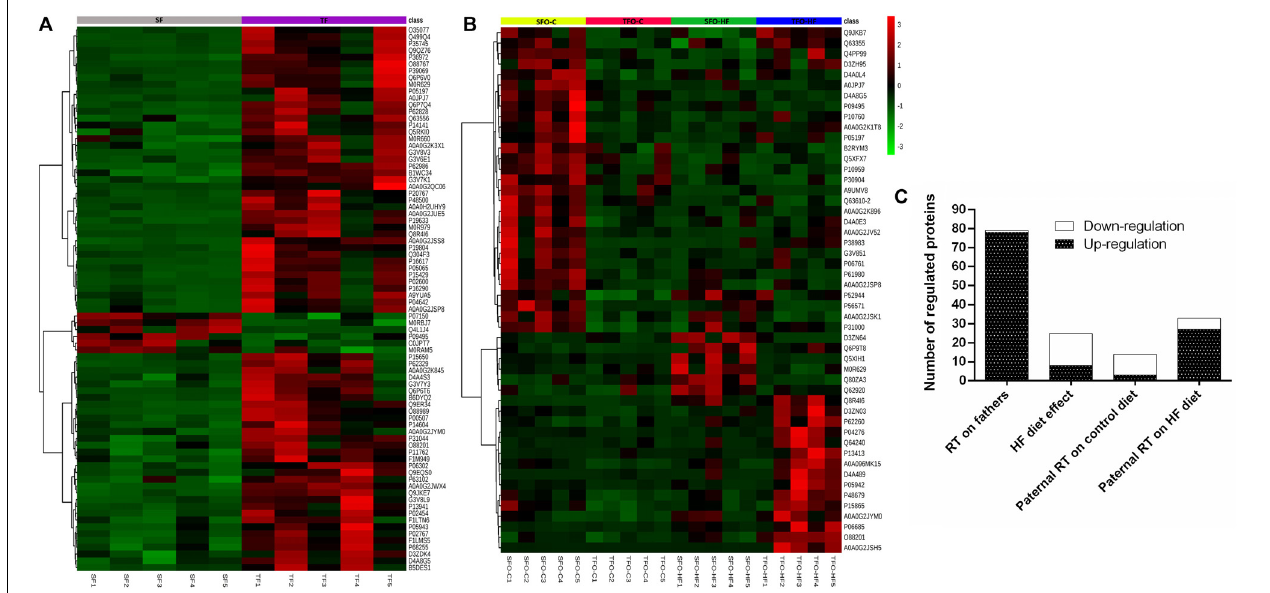
FIGURE 3 | Heat map of the changes for each animals in the fathers (A) and offspring groups (B) . Each horizontal line represents an individual protein. The top 80 proteins regarding fathers and 50 from offspring, respectively. SF, sedentary fathers; TF, trained fathers; SFO-C, offspring from sedentary fathers, exposed to control diet; TFO-C, offspring from trained fathers exposed to control diet; SFO-HF, offspring from sedentary fathers exposed to high-fat diet; TFO-HF, offspring from trained fathers exposed to a high-fat diet. Read counts for each animal has been plotted as log2. Green and red indicate a decrease and increase of protein abundance levels, respectively. Overall number of regulated (down-regulation or up-regulation) protein for training and diet as factors (C) .